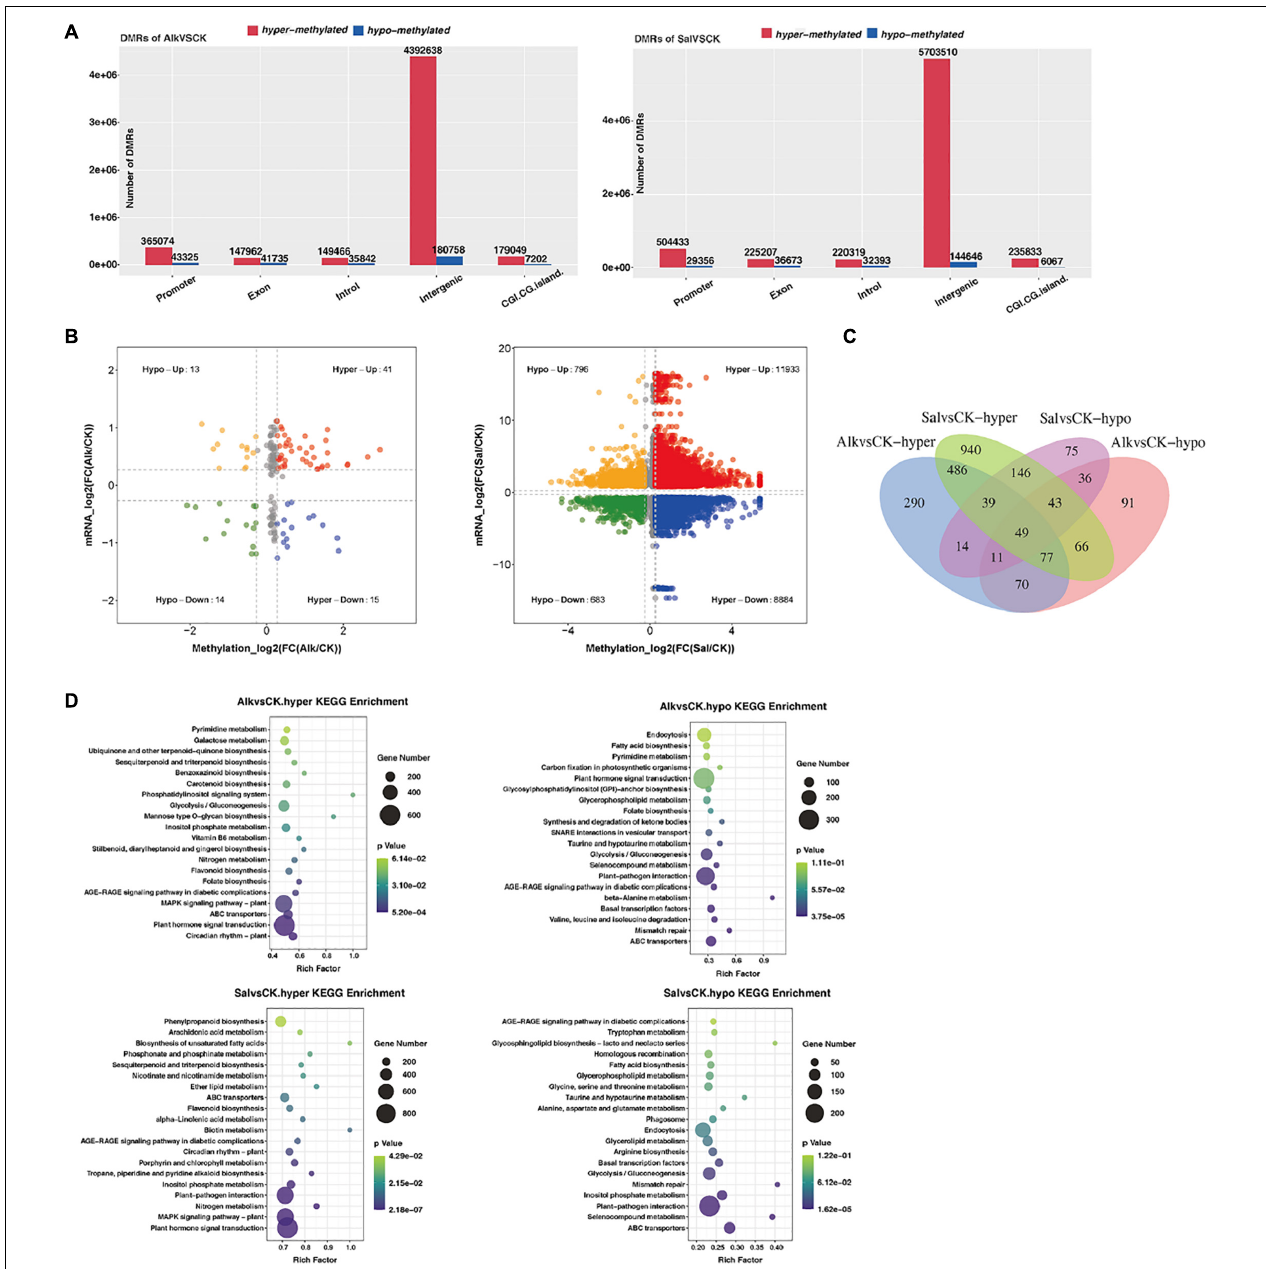
FIGURE 6 | Analysis of methylation level and enrichment between samples. (A) Histogram of gene structure statistics of methylation genes. The x -axis represents the functional regions of different genes, the y -axis represents the number of DMRs, red represents up-regulated DMR, and blue represents down-regulated DMR. (B) Four-quadrant diagram of DNA methylation and mRNA. The two groups are drawn on the basis that all points are less than 0.05, or, the P -values of all points are less than 0.05. One point represents a DMR area, the log2 of -inf is 0, and the maximum value of inf is added to 0.00001 and then taken log2 value. (C) Venn diagram of hyper/hypo methylated genes among G. barbadense under salt and alkaline stress. (D) KEGG pathway enrichment of hypermethylated and hypomethylated genes in G. barbadense under salt and alkaline stress. The size of the circle represents gene numbers, and the color represents the P -value. Alk vs. CK, alkaline stress versus control; Sal vs. CK, salt stress versus